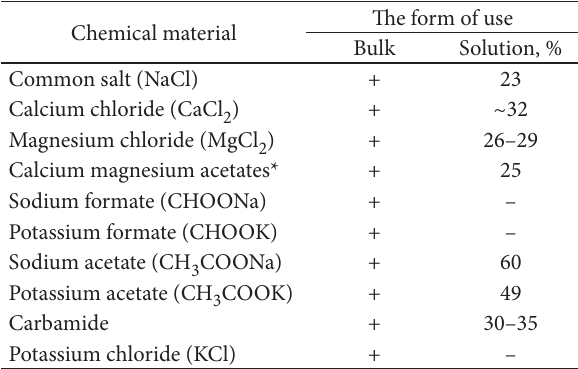
Table 1. The list of chemical materials most widely used for winter maintenance